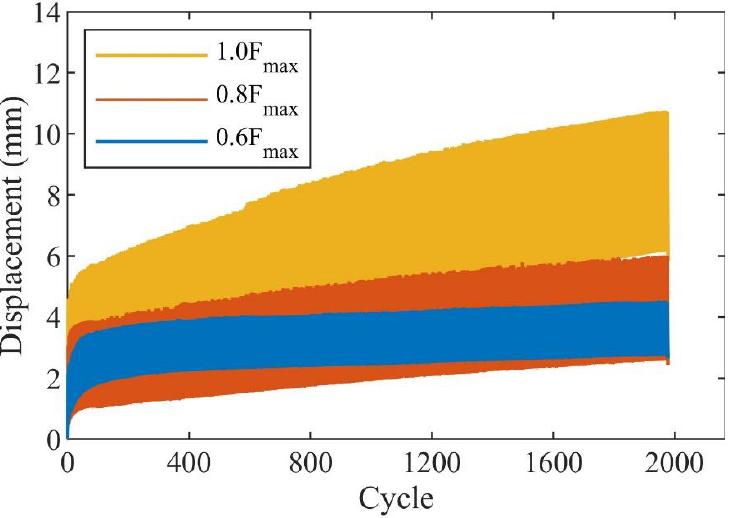
Figure 13. Time history of the displacement of variable cyclic loading amplitudes (θ = 45°).